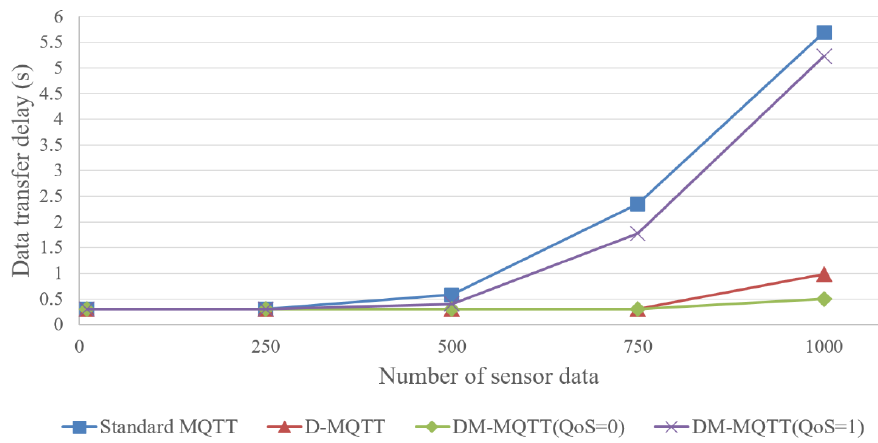
Figure 8. Changes in data transfer delay depending on the number of data samples.